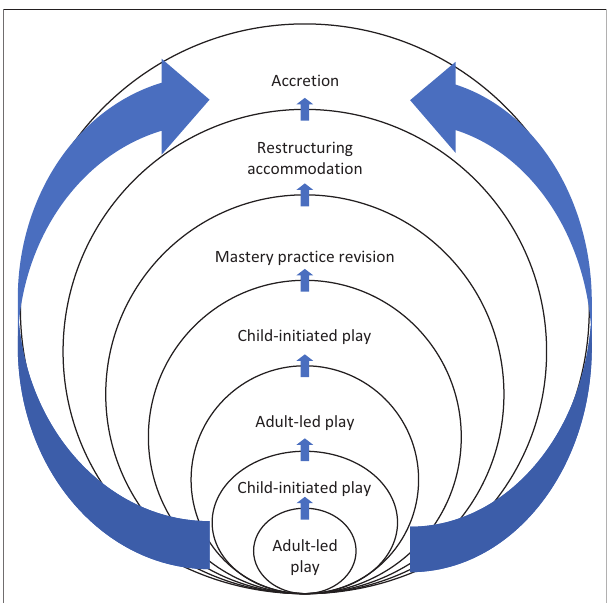
FIGURE 1: The theory of play as a spiral of